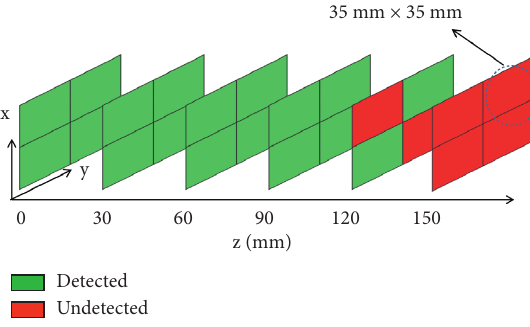
Figure 10: Three-branch antenna measurement